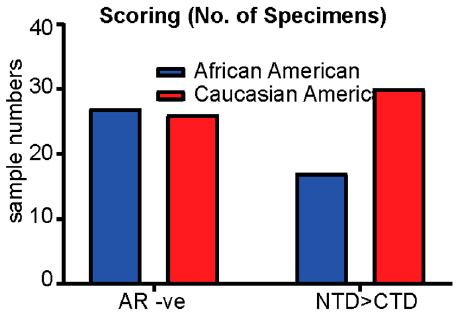
Figure 3. Expression of AR and AR-SVs. AR staining with antibodies binding to the N-terminus domain (NTD) and ligand-binding domain (LBD) was quantified and represented as H-score. The bars represent the number of specimens that did not stain with both the antibodies and the number of specimens that stained with NTD antibody at least 2.0-fold more than the LBD antibody. No statistical significance was observed between the groups.